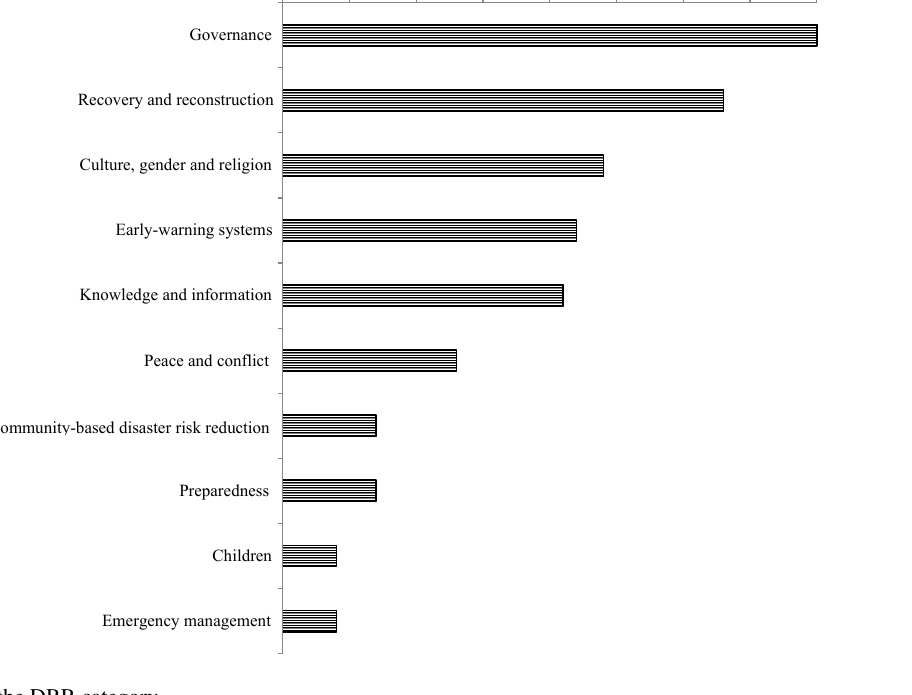
Figure 3. Key topics in the DRR